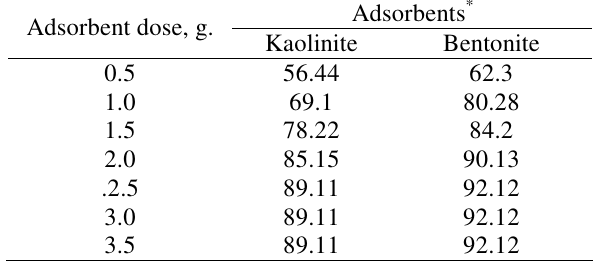
Table 5. Effect of adsorbent dosage on percent removal of nickel(II) Adsorbent dose,